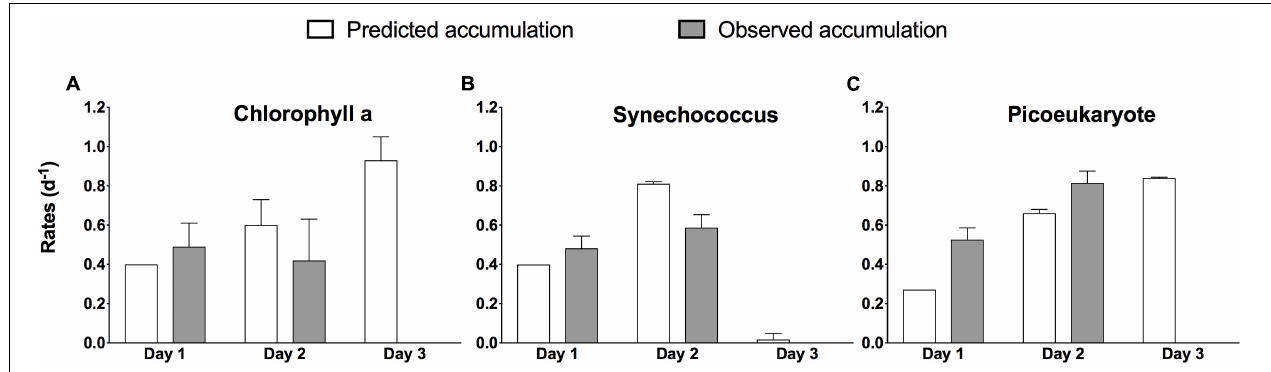
FIGURE 5 | Comparison between accumulation rates predicted experimentally (white bars) and those observed in situ (gray bars) during the occupation of S4 during NAAMES II. Rates are based on change in total chlorophyll a (A) and based on change in abundance for Synechococcus (B) , and pico-eukaryotes (C) and are given per day ± 1 SD of the mean of duplicate experiments, except for Day 1 predicted rates (no error estimate). Nanoeukaryotes contributed < 2% of total abundance and are omitted.